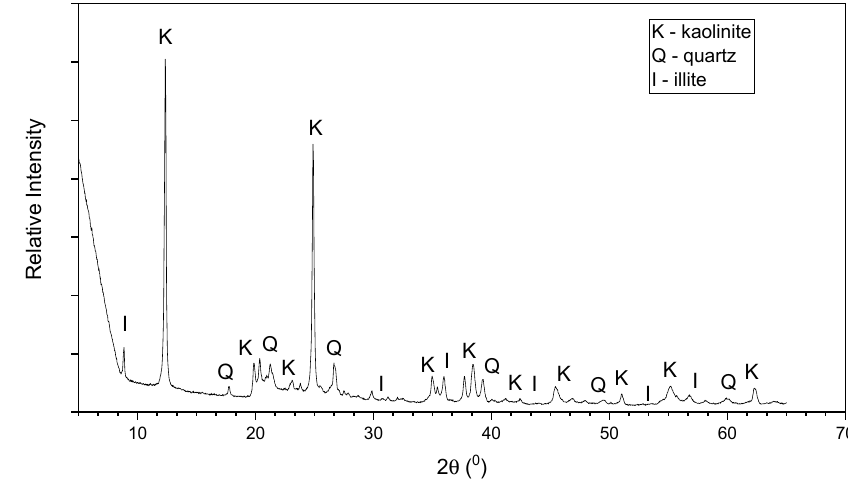
Figure 1. X-ray diffraction (XRD) pattern of the clay.